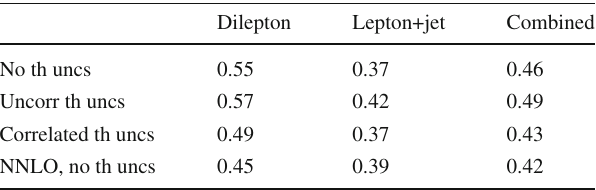
Table 4 The experimental χ 2 per data point for the CMS 13 TeV top dilepton and lepton+jet rapidity distributions, comparing the original result of the NLO fit with no theory uncertainties to the fit with theory uncertainties, and then including the correlated shift in the autopredic- tions. Also shown for comparison is the result in a NNLO fit with